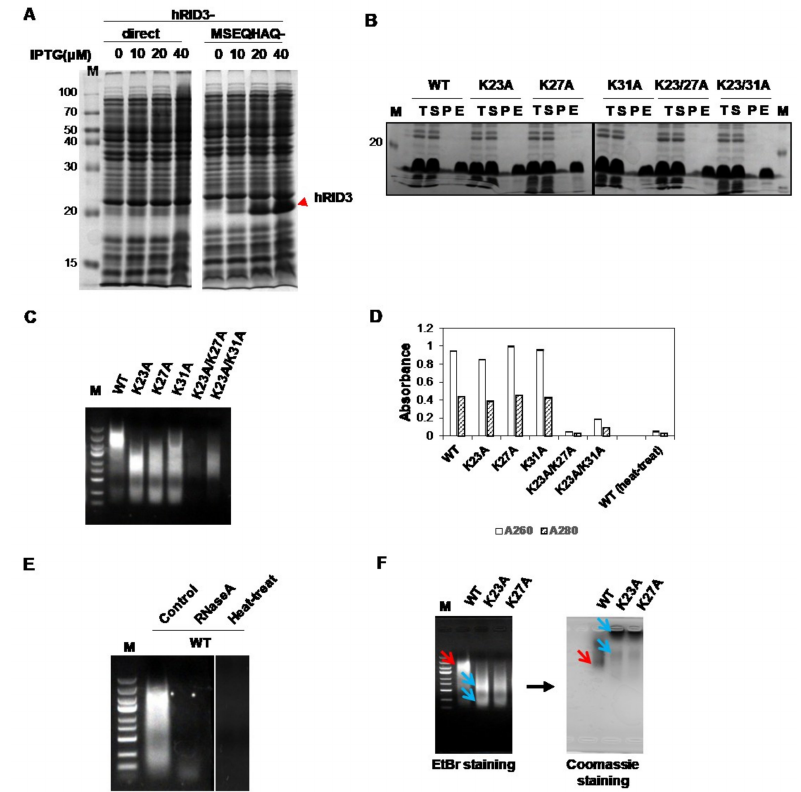
Figure 1. Expression and purification of wild-type and mutant hRID in E. coli and confirmation of NA binding ability. ( A ) Recombinant hRID with or without the N-terminal expression-enhancing tag was expressed in E. coli by induction with 0–40 µ M Isopropyl β - D -1-thiogalactopyranoside (IPTG). Expressed protein is indicated by a red arrowhead. ( B ) Mutant hRIDs were expressed in E. coli and purified using Ni-affinity chromatography. T, S, P, and E indicate total lysate, supernatant, pellet, and eluted fraction, respectively. ( C ) Purified proteins were loaded onto an agarose gel and the co-purified nucleic acids (NAs) were detected by EtBr staining. ( D ) Absorbances at 260 and 280 nm of the eluted fractions. The values in the graph represent the means ± standard deviations of the triplicate. ( E ) RNaseA and heat sensitivities of the co-purified NAs were examined. ( F ) Co-purified NAs with hRID (WT, K23A, and K27A) were analyzed by agarose gel electrophoresis, and the gel was stained with EtBr and Coomassie brilliant blue. Colocalized NAs and protein are indicated by the red arrows, and the dissociated NAs and protein are indicated by the blue